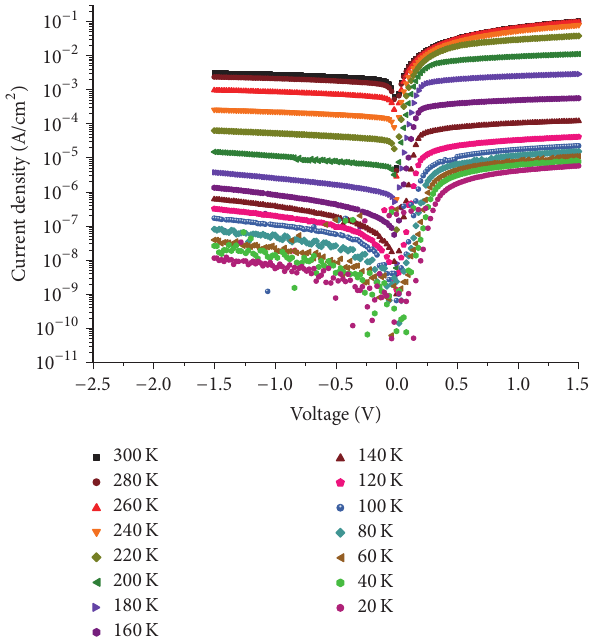
Figure 3: Semilogarithmic plot of the dark J-V curves of the present heterojunctions under forward and reverse bias conditions in the voltage range of − 1.5 to +1.5V at temperatures from 300 down to 20 K.